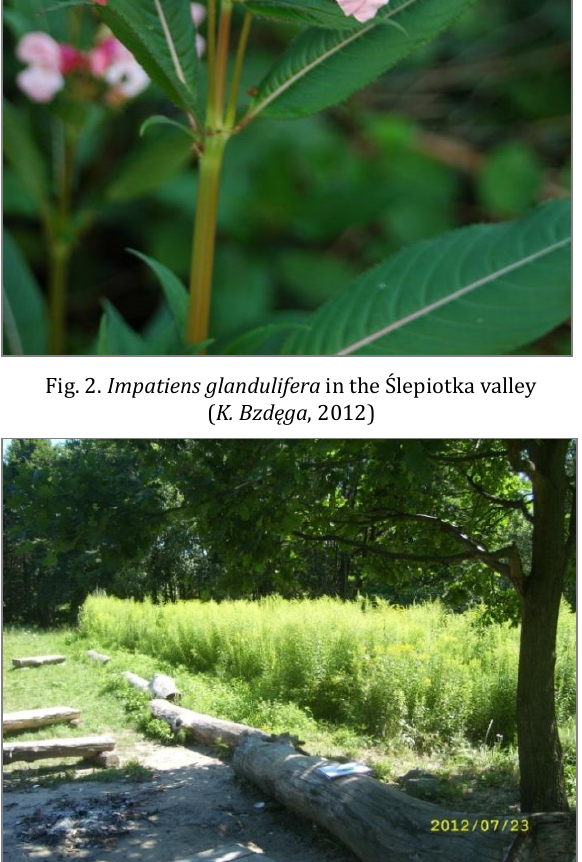
Fig. 4. A patch of Solidago canadensis on the bank of the Ślepiotka River ( M. Frelich ,